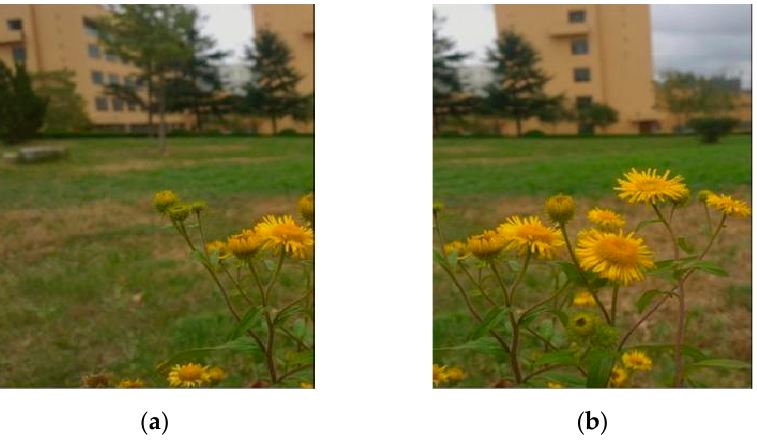
Figure 3. The original images for T1: ( a ) Reference image; ( b ) Be-registered image. Reference image is regarded as a standard reference image without any changes, and Be-registered image is mapped to the former through dynamic spatial transformation.